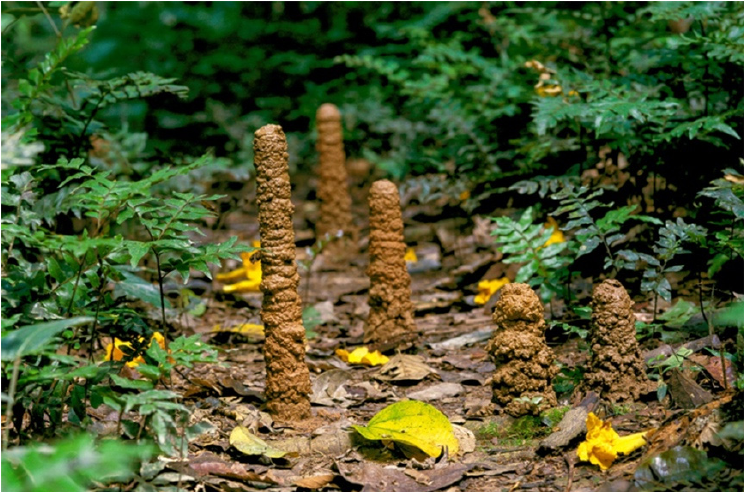
Figure 6. Exit tunnels built by Fidicina chlorogena Walker, 1850 (now Guyalna chlorogena (Walker, 1850)). Image courtesy of André Bärtschi, Vaduz, Liechtenstein.